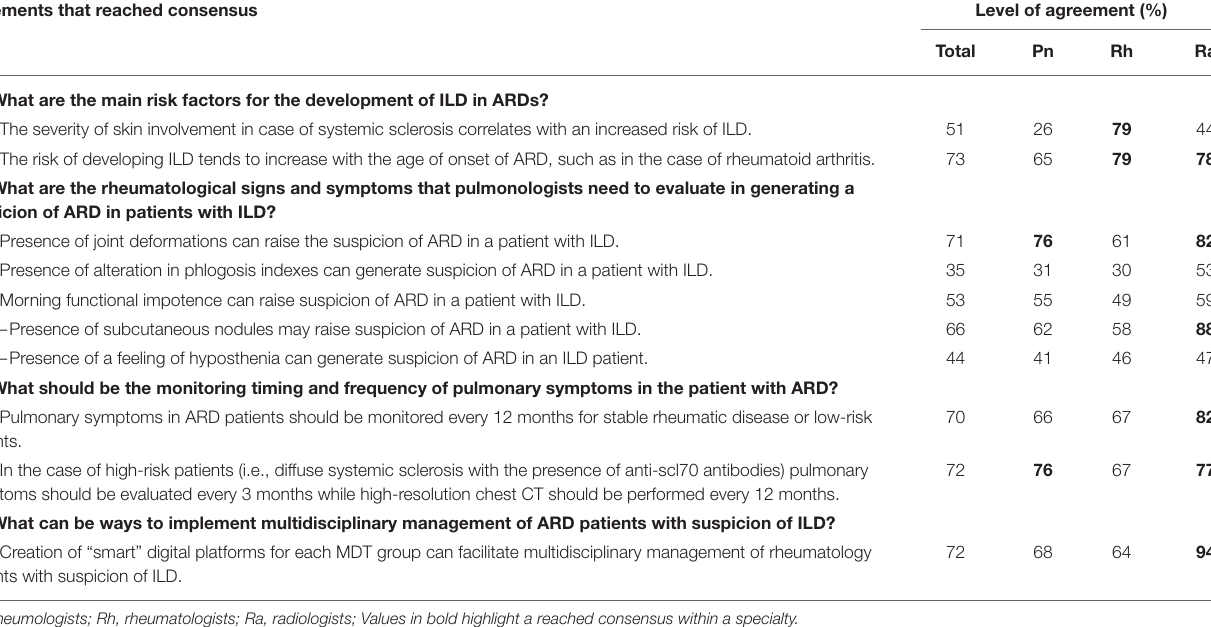
TABLE 4 | Check list of red flags sign or symptom suggestive of ARD. Skin manifestations (cutaneous sclerosis, purpura of the lower limbs, Gottron’s papules, cutaneous vasculitis, photosensitivity, palmar erythema, “mechanic’s